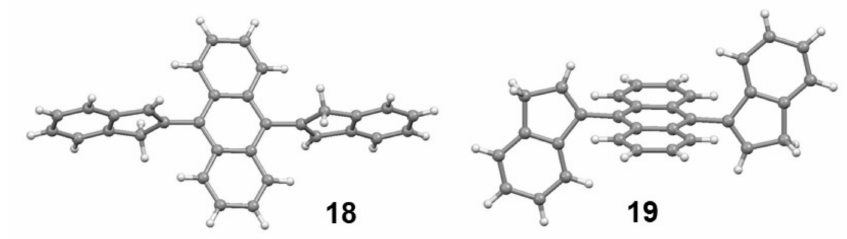
Figure 9. Structures of 9,10-di(2-indenyl)anthracene, 18 , and anti -9,10-di(3-indenylanthracene, 19